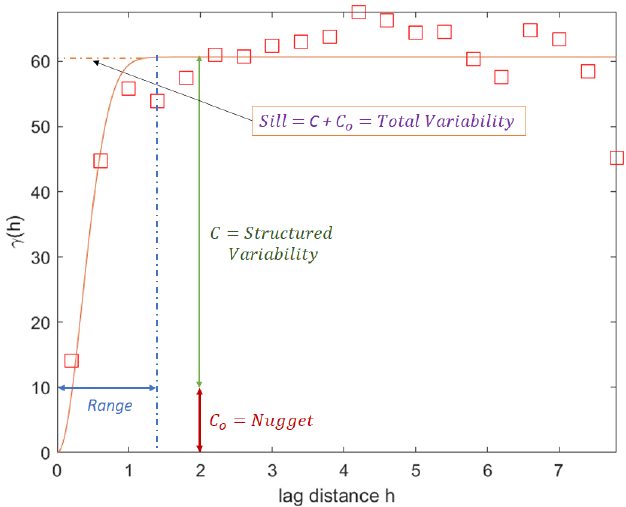
Figure 6. Graphical description of the variogram (variation in relation to distance between two points) and its components: range, nugget and